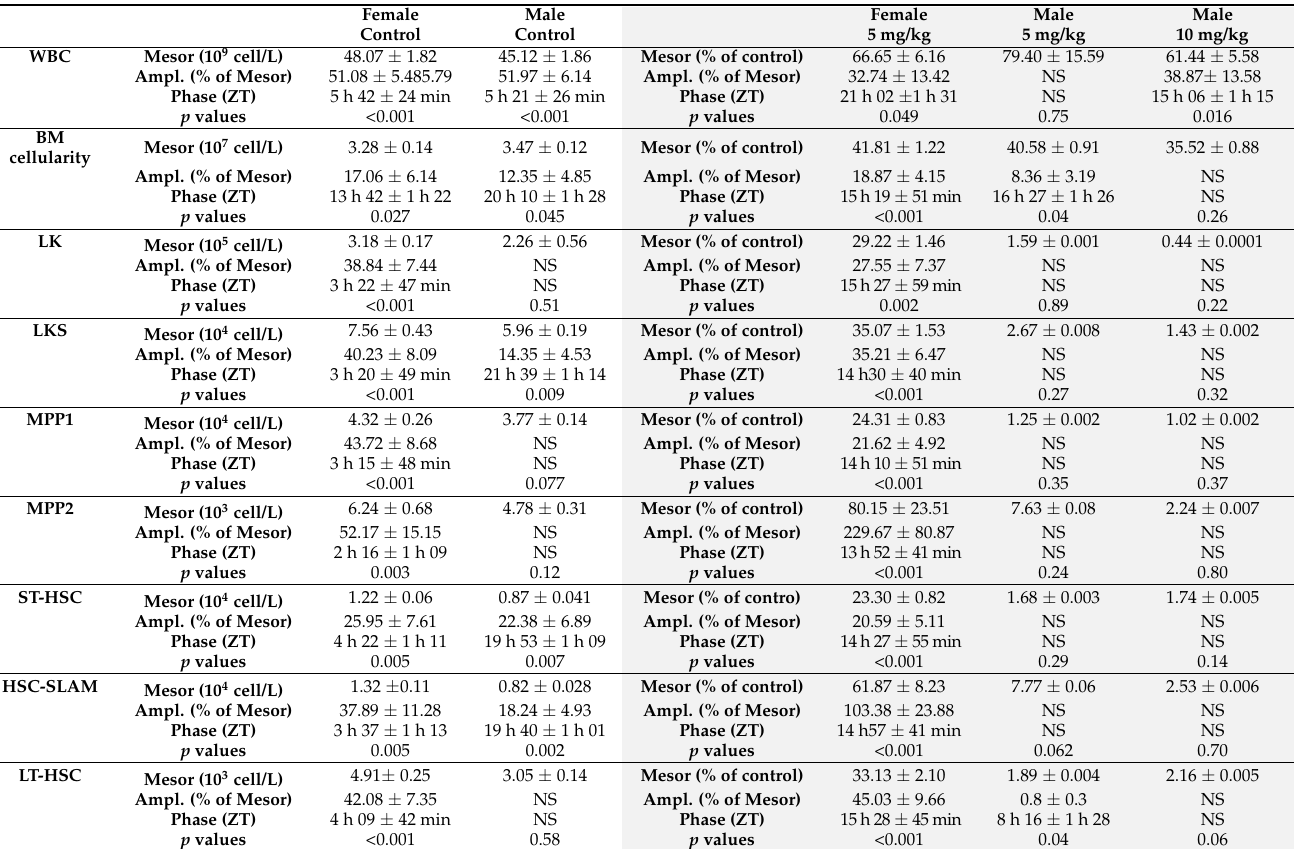
Table 1. Cosinor parameters related to WBC, BM cellularity and progenitor counts, in physiological and treated